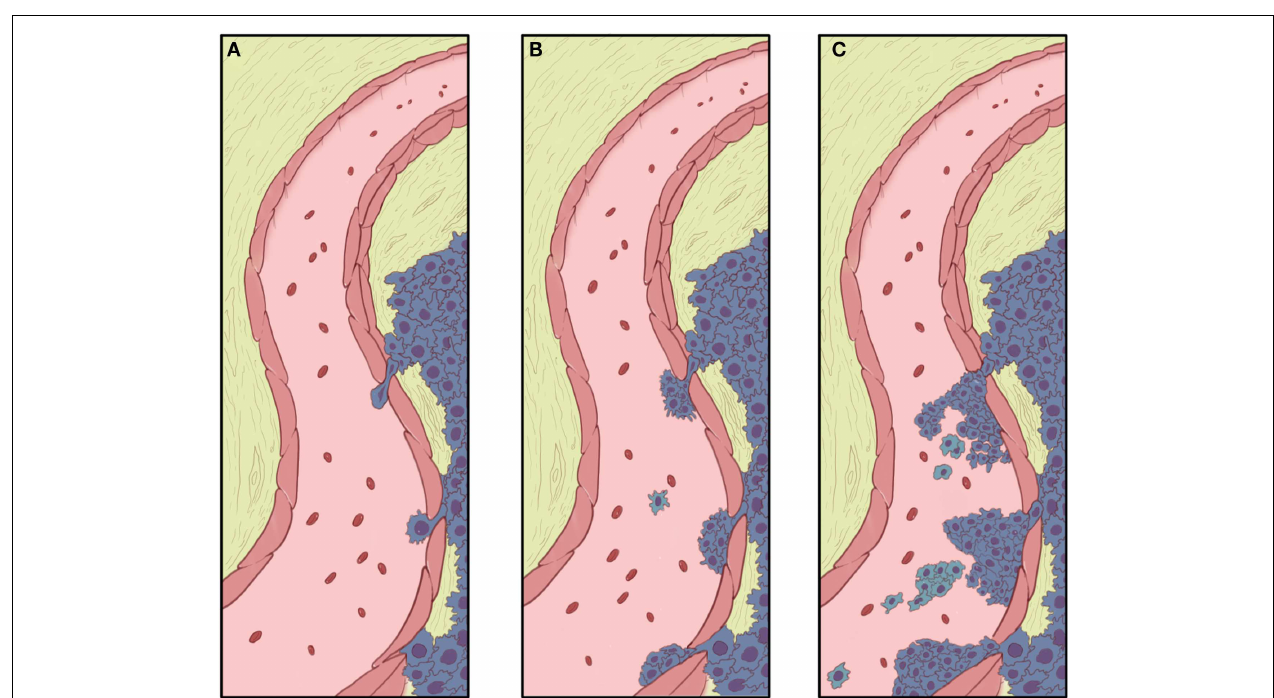
between and through gaps in the endothelial cells. (C) With further mass migration, tumor cells begin obstructing the flow of blood through the vessel, and encounter red cells, platelets, and other blood components. A tumor thrombus may occlude blood flow and, is the vessel is large enough, cause symptoms of deep venous thrombosis. Clumps of tumor and individual tumor cells detach from the main mass of tumors and are carried away in the blood stream. Individual cells would be subject to anoikis when loose in the blood stream. Some cells in tumor clumps may be protected from anoikis by their attachment to other cells in the